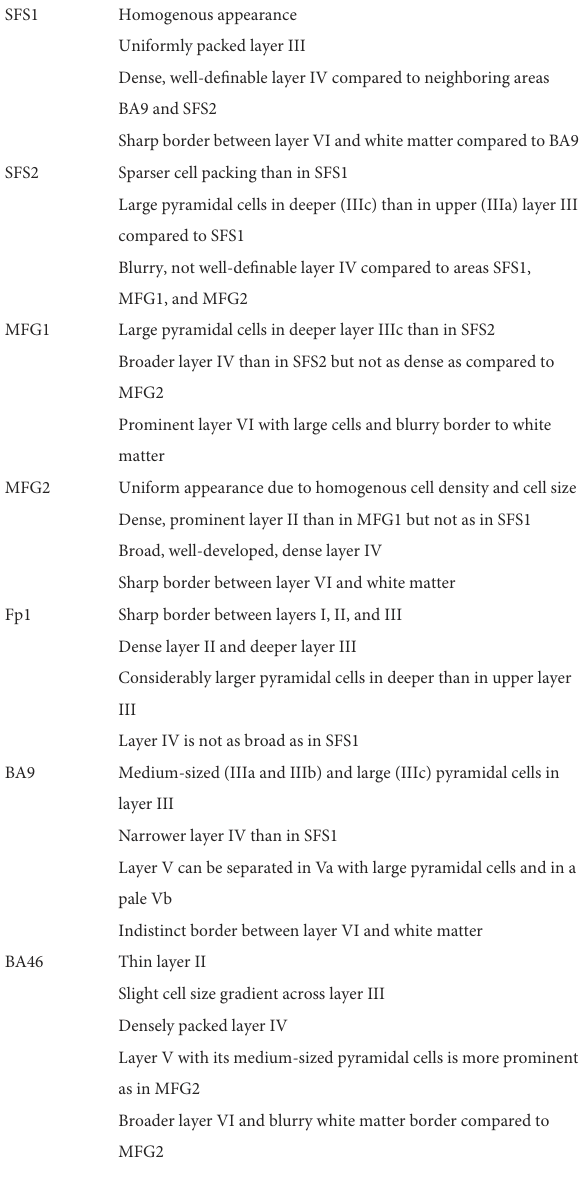
TABLE 2 Cytoarchitectonic characteristics of anterior DLPFC areas SFS1, SFS2, MFG1, and MFG2 and neighboring areas.